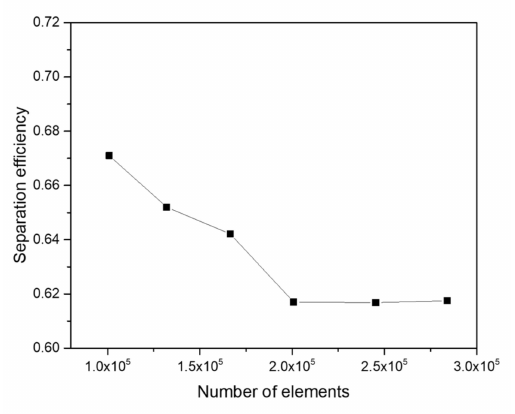
Figure 4. Grid systems: ( a ) stage a, ( b ) stage b, ( c ) stage c, ( d ) stage d.